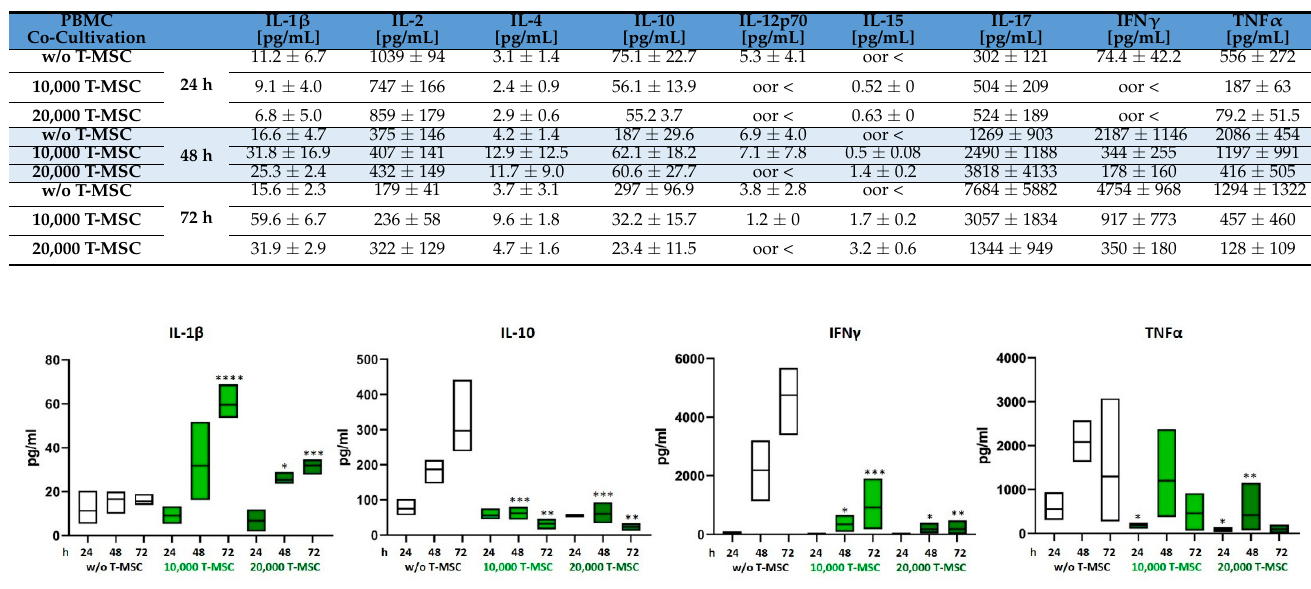
Figure 2. Altered production of pro-inflammatory cytokines after co-cultivation with T-MSC. PBMC were stimulated with IL-2/OKT3 and co-cultivated with T-MSC. Supernatants of co-cultures were analyzed after 24, 48, and 72 h. The cytokine levels were determined by Multiplex analyses. Boxplots show distribution and mean, n = 4; * p < 0.05, ** p < 0.01, *** p < 0.001, **** p < 0.0001 in an unpaired Student’s t test (cytokine value with T-MSC vs. w/o T-MSC for each time point). T-MSC: tumor- derived mesenchymal stromal cell; IL: interleukin; IFN γ : interferon-gamma; TNF α : tumor necrosis factor alpha.